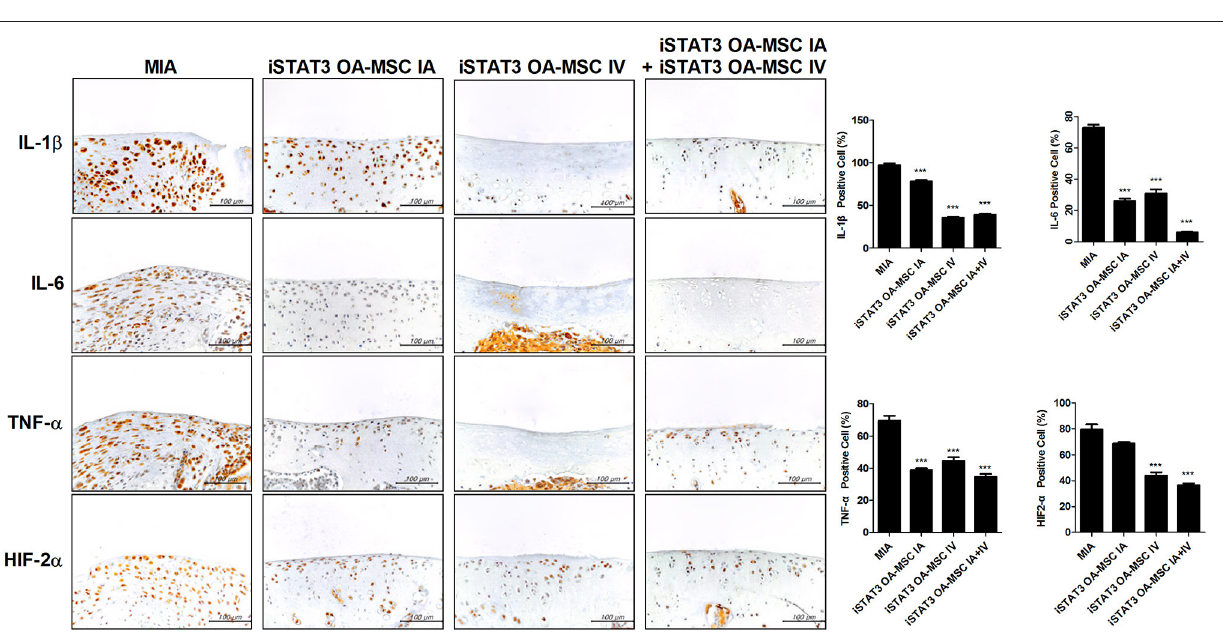
FIGURE 6 | Expression of inflammatory mediators by administration of STAT3-inhibited OA-MSCs in articular cartilage of MIA-induced OA rats. Immunohistochemical staining of femoral condyle was performed to measure the expression of IL-1 β , IL-6, TNF- α , and HIF-2 α after multiple injections of IA and IV iSTAT3 OA-MSCs in knee joint tissues of MIA-induced OA rats. The percentage positive cells for each antibody are shown at the right. Data represent the mean ± SEM of 3 independent experiments (*** P < 0.001).